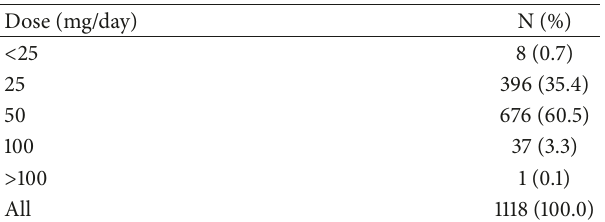
Table 4: Initial daily dose of eplerenone in eplerenone-na¨ıve